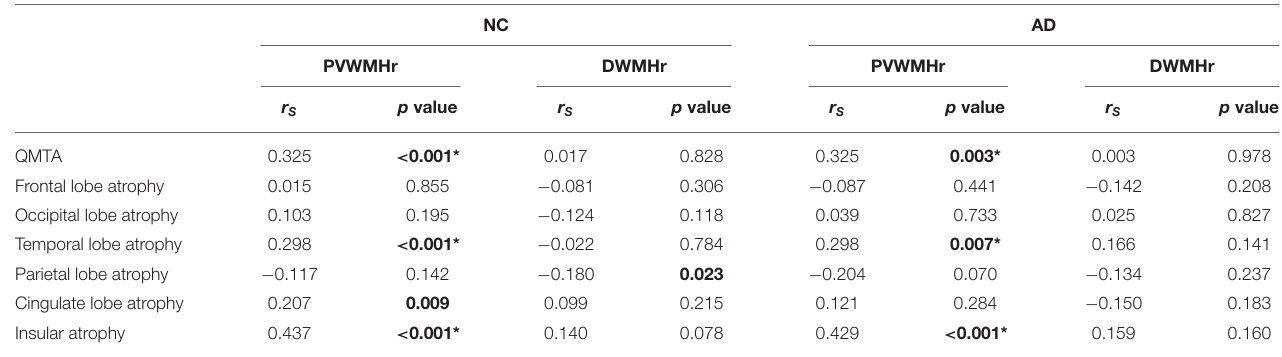
TABLE 4 | Correlation analysis between regional brain atrophy and different types of WMHr.